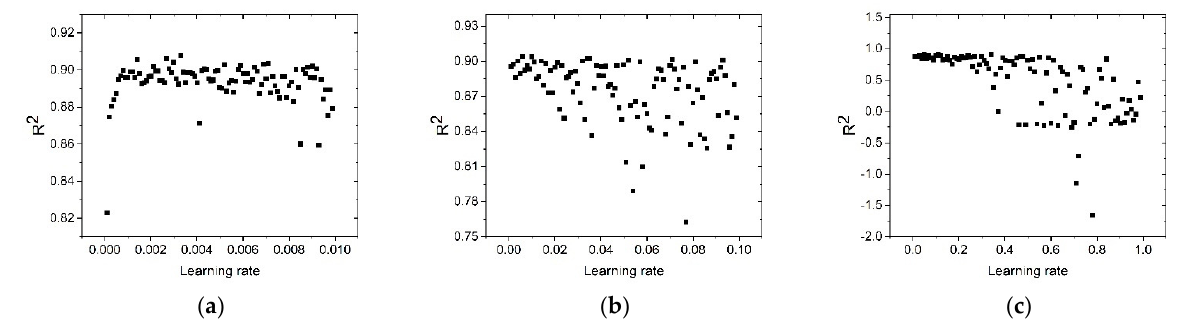
Figure 7. Optimization of the initial learning rate: ( a ) learning rate between 0 and 0.01, ( b ) learning rate between 0.01 and 0.1, ( c ) learning rate between 0.1 and 1.